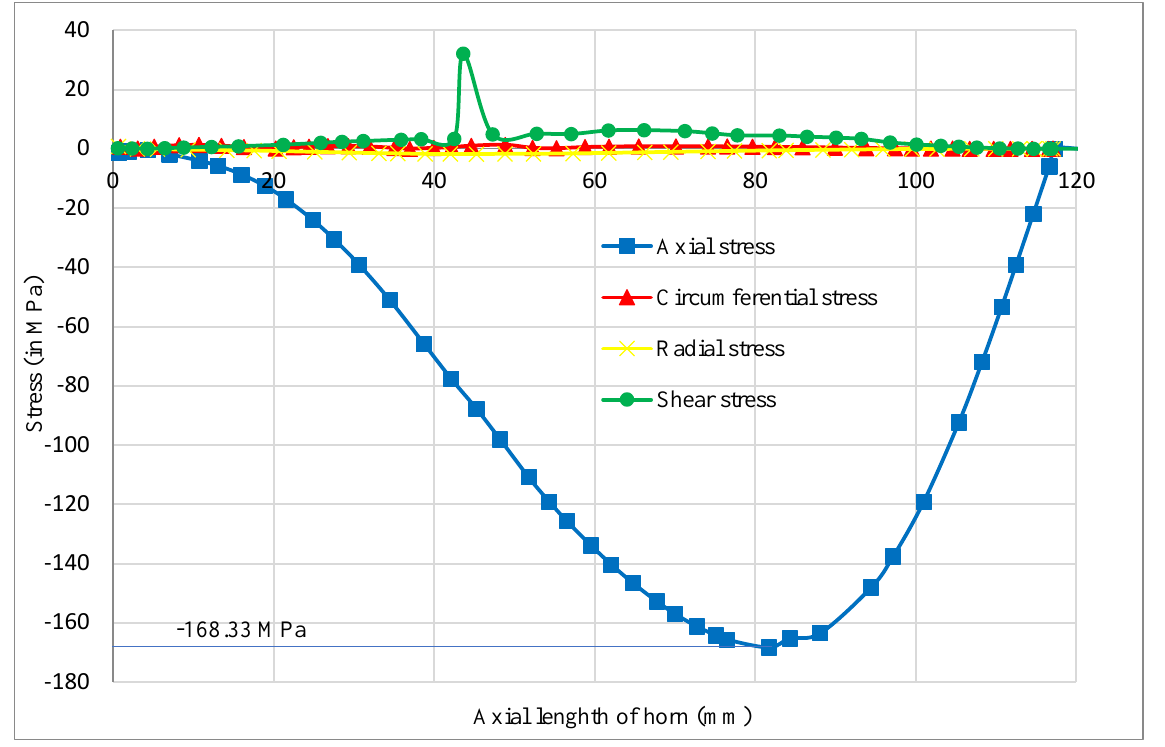
Figure 11. Stress variation along the axial length of titanium catenoidal horn